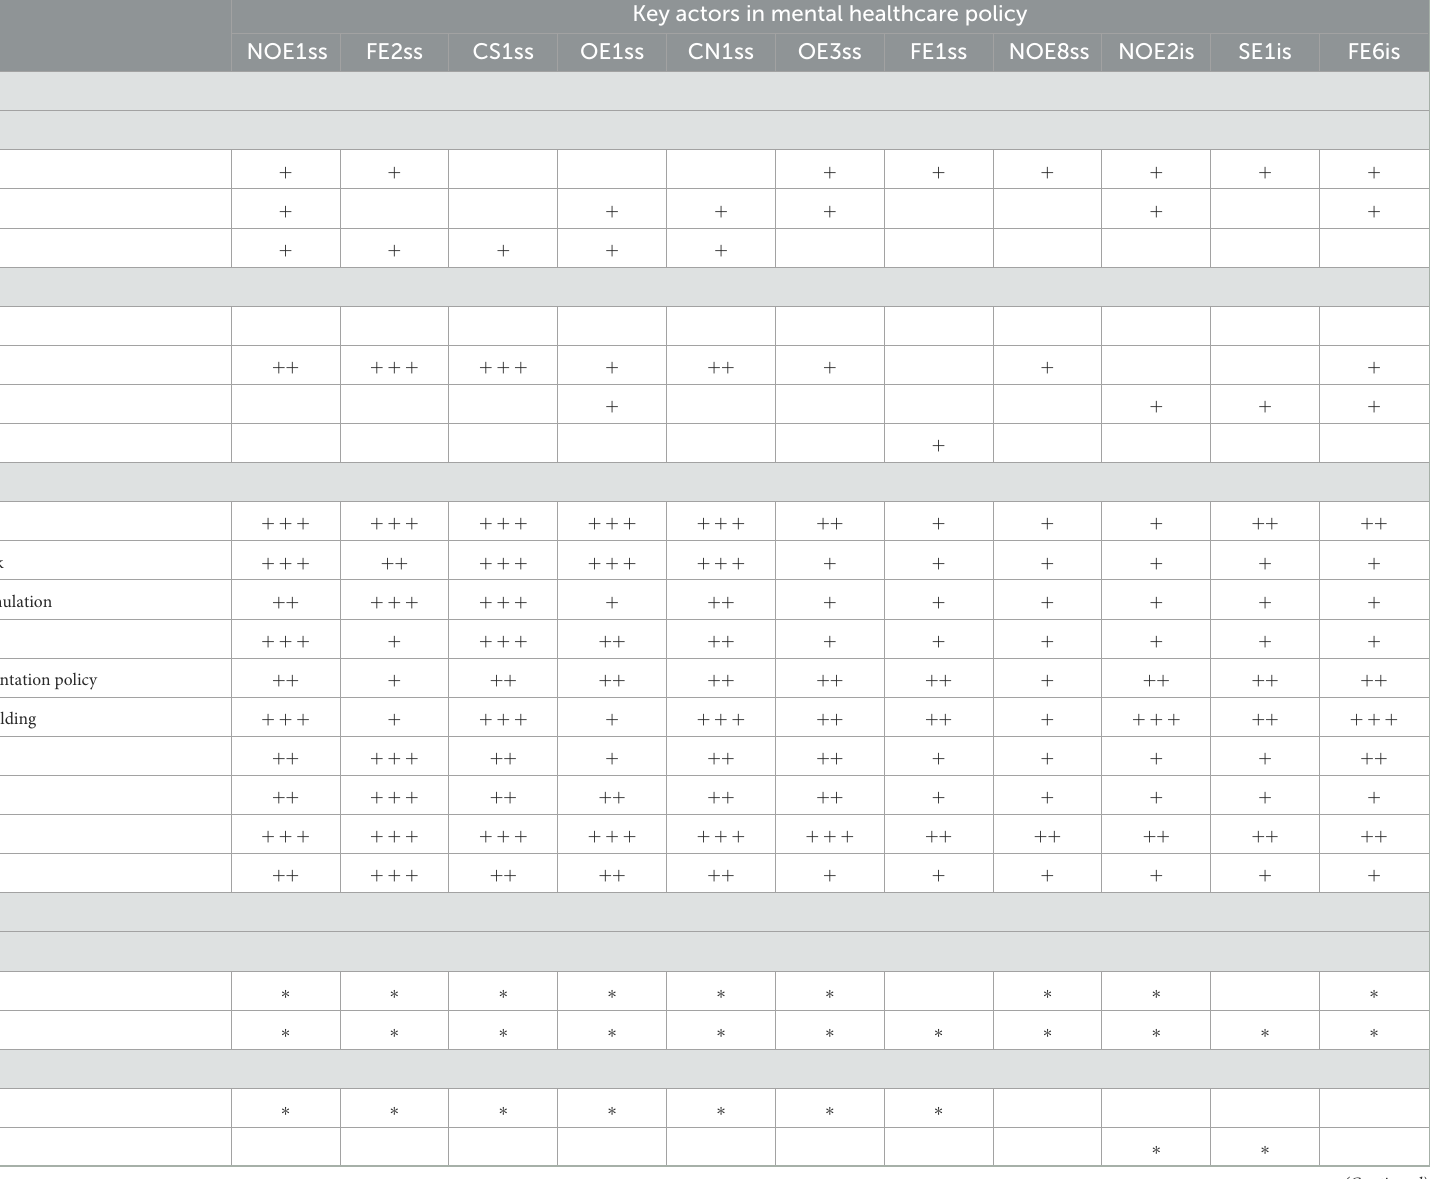
Key actors in mental healthcare policy